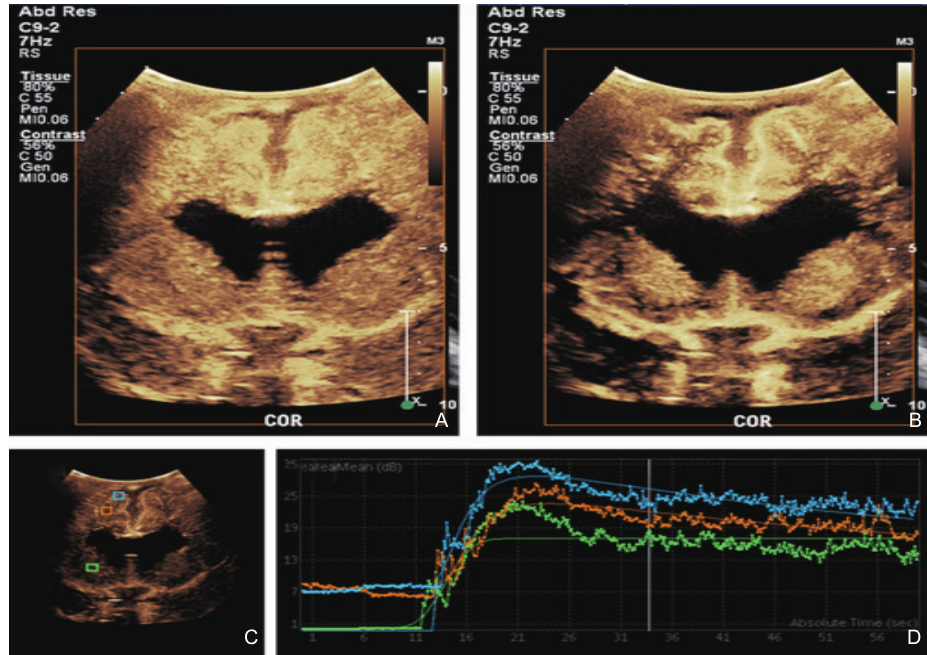
Figure 5 Time-dependent changes on CEUS imaging using perfusion kinetics in the brain of a 9-month-old following cardiac arrest. (A) a coronal CEUS image 15 seconds after contrast injection, showing avid perfusion to the cortical region; (B) a coronal CEUS image 20 seconds after contrast injection, showing prolonged hyperperfusion to the peripheral gray and white matter; (C) Regions of interest selected; (D) unique perfusion kinetic curves generated in a region-specific manner. Reproduced from